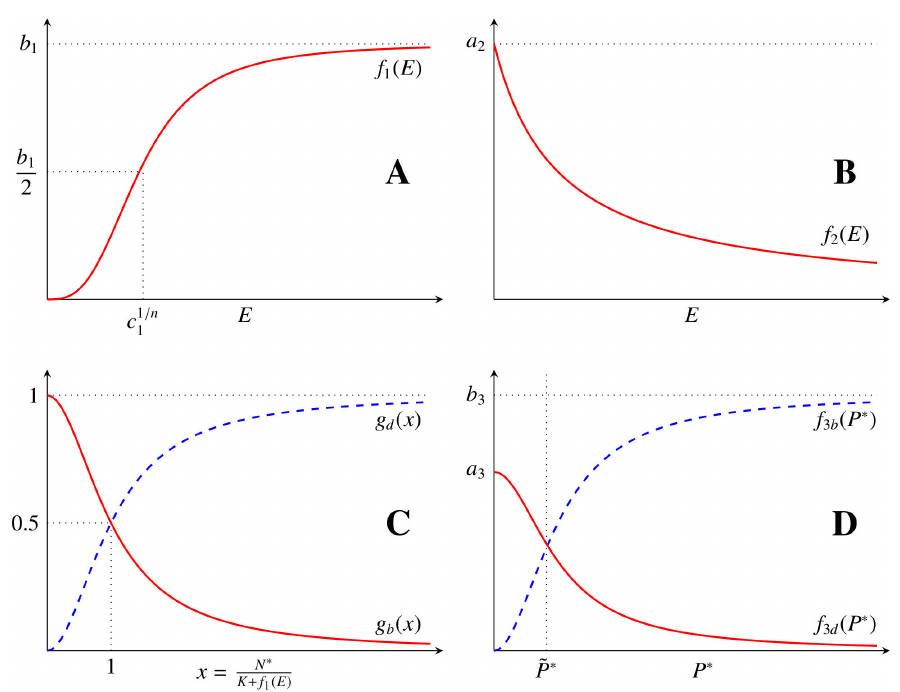
Fig 1. Rate dependences characterizing tumour, vascular and VEGF dynamics. (A) Effective nutrients received f 1 ( E ) for c 1 = 1 and n = 3. (B) VEGF production rate f 2 ( E ), dependence on the effective nutrients available. (C) Rates of proliferation (solid line) and death (dashed line) for the tumour cells with n 1 = 2. (D) Rates of proliferation and death for the vessels dependence with VEGF concentration for n 3 = n 4 =